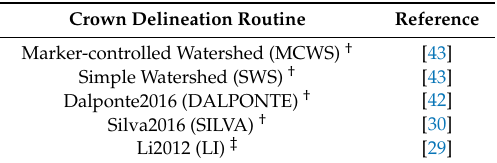
Table 1. Five automated LiDAR-based individual tree crown delineation routines were evaluated in this study. † Four routines are surface-based methods applied to rasterized canopy height models. ‡ The fifth routine is a 3D method applied to a point cloud. All routines were implemented in the R package lidR, developed by Roussel and Auty [42].